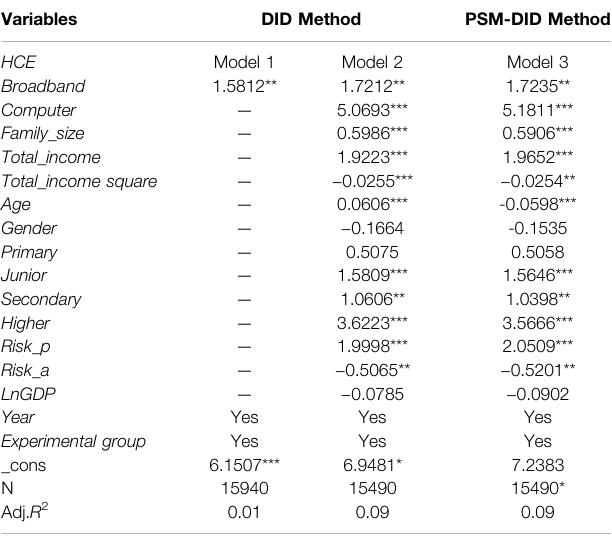
TABLE 3 | Results of model